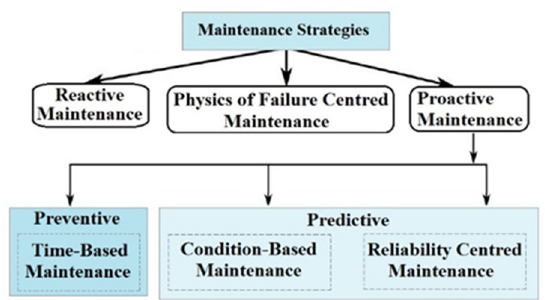
Figure 21. Maintenance strategies.